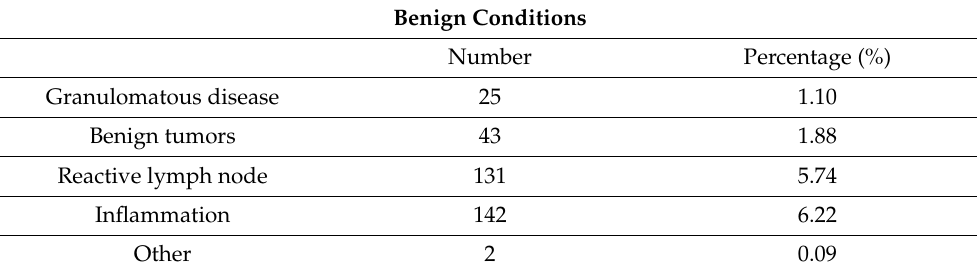
Table 2. Definitive cytological diagnosis on 2282